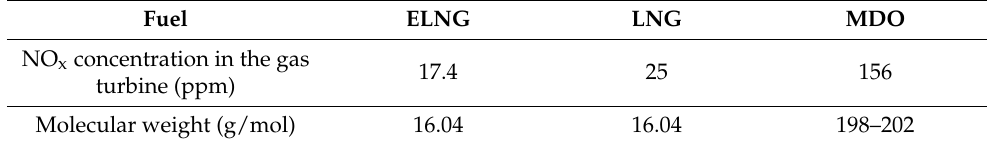
Figure 7. Performance of various propulsion systems of the large container ship travelling between Shanghai and Hamburg. I/R: intercooler/reheater CCGT; S: simple CCGT; Diesel: two-stroke diesel engine; W: winter; Mid: midseason; S: summer season; ELNG: enhanced liquified natural gas; MDO: marine diesel fuel; LNG: liquified natural gas. Table 6. Theoretical parameters of different propulsion systems and fuels. Fuel ELNG LNG MDO NO x concentration in the gas turbine (ppm) Molecular weight